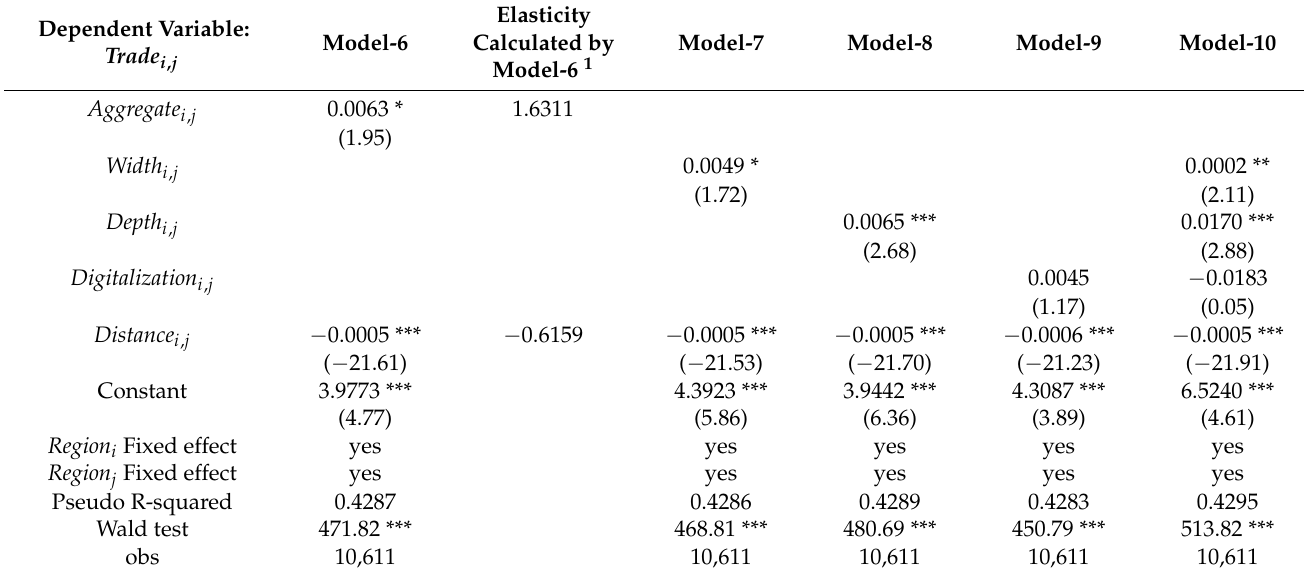
Table 4. Results of Poisson pseudo-maximum likelihood with fixed effects